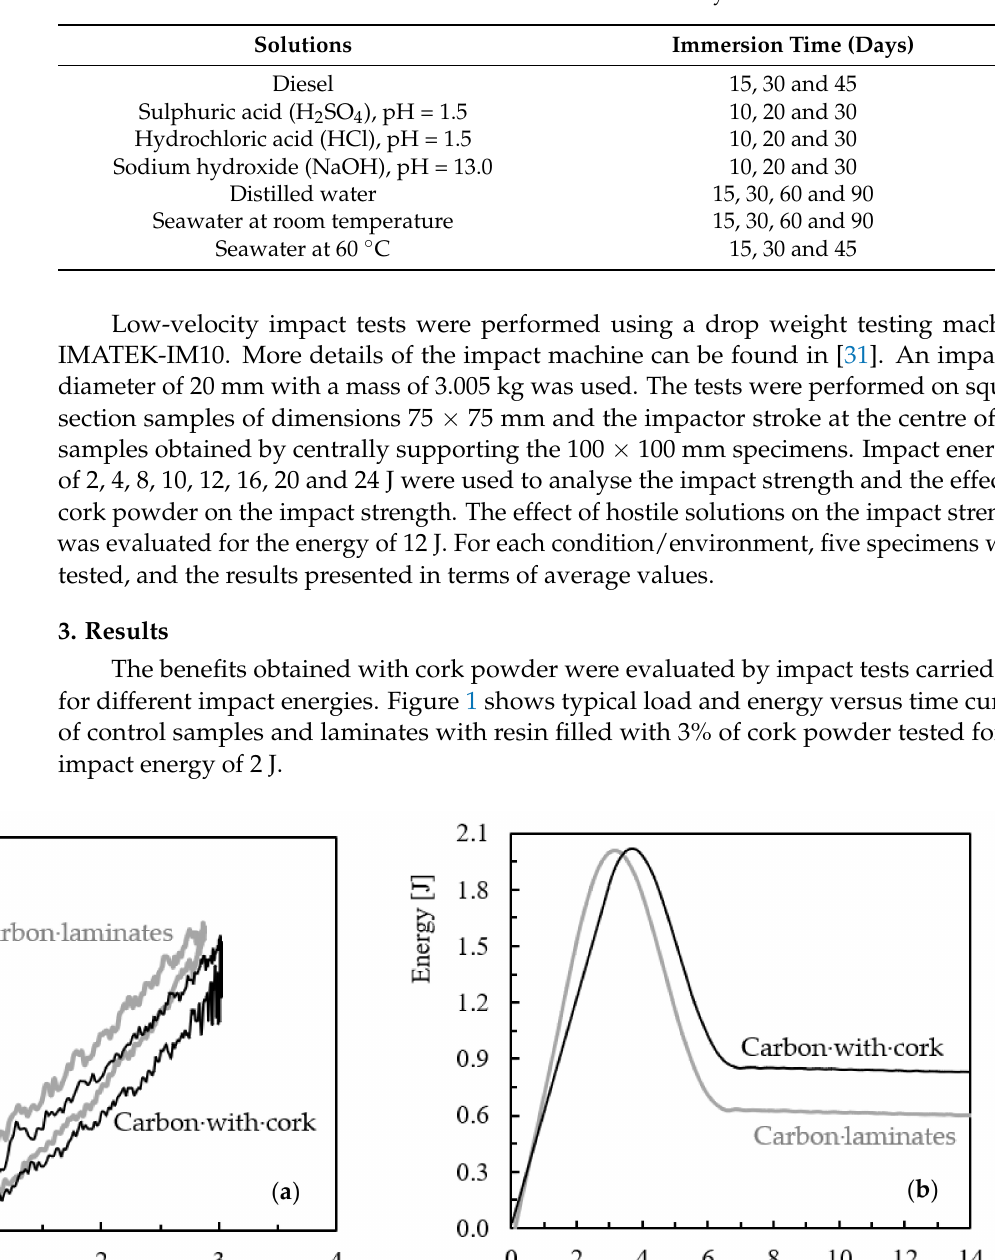
Table 1. Different solutions and immersion times used in this study.